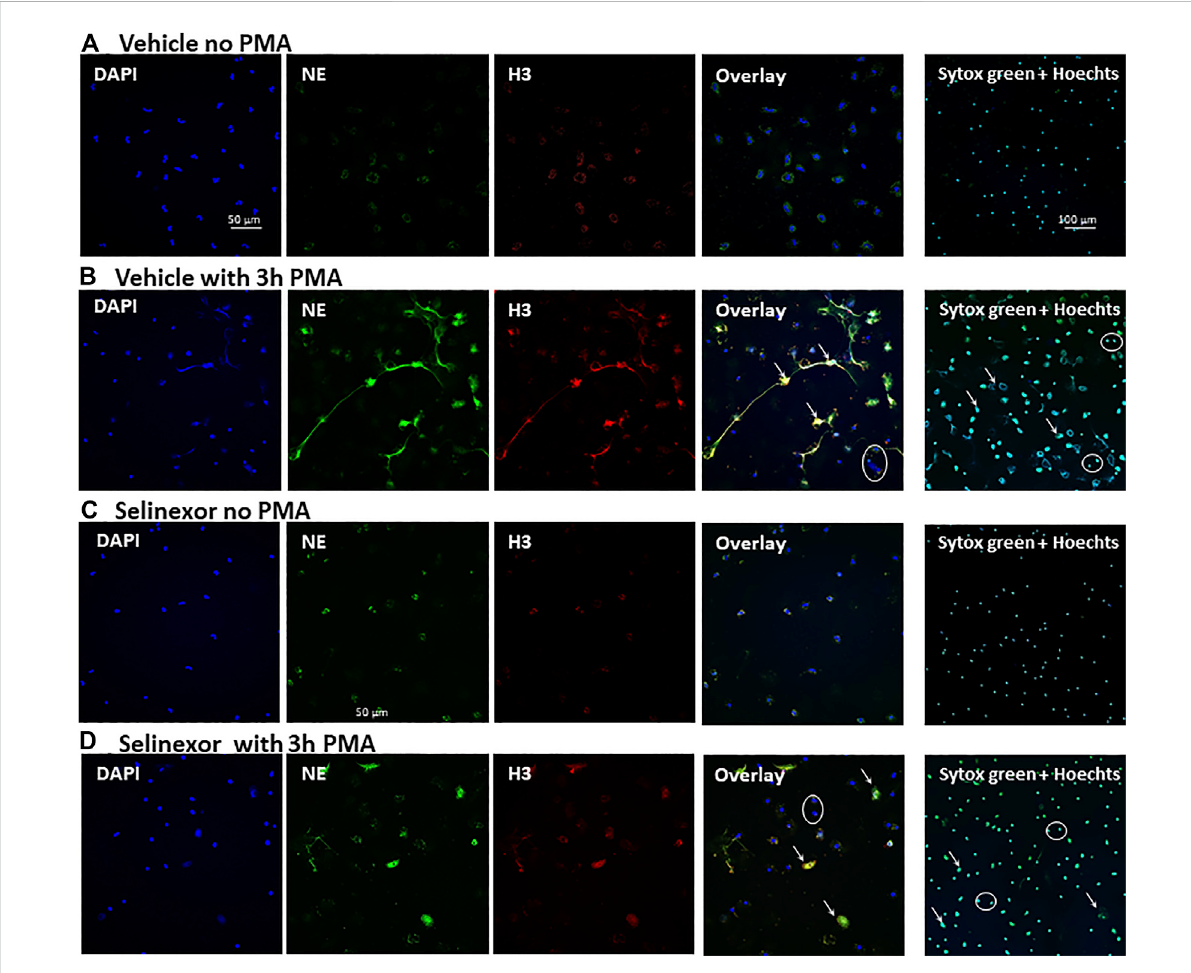
Inhibitory effect Selinexor on NETs formation, as seen in microscopy. Immuno fl uorescent (IF) staining demonstrating a signi fi cant inhibition of NETs formation following incubation of neutrophils with 50 nM Selinexor for 2 h vs. vehicle. Cells were activated with 100 nM PMA for 3 h and compared to non-activated cells. (A) Neutrophils were incubated with vehicle and were not activated. No NETs release was seen (B) Neutrophils wereincubatedwithvehicleandactivatedwithPMA.Signi fi cantNETsreleasewasseen. (C) NeutrophilswereincubatedwithSelinexorandwere not activated. No NETs release was seen. (D) Neutrophils were incubated with Selinexor and activated with PMA. Minor NETs release was seen. Columns, from left to right: DAPI nuclear staining (blue), Neutrophil elastase (green), Histone 3 (red)and the Overlay of all three images. On the right columns Sytox green and Hoechst 33342 double staining. Representative NETs-forming neutrophils are indicated with white arrows, while neutrophils not forming NETs are signed with white